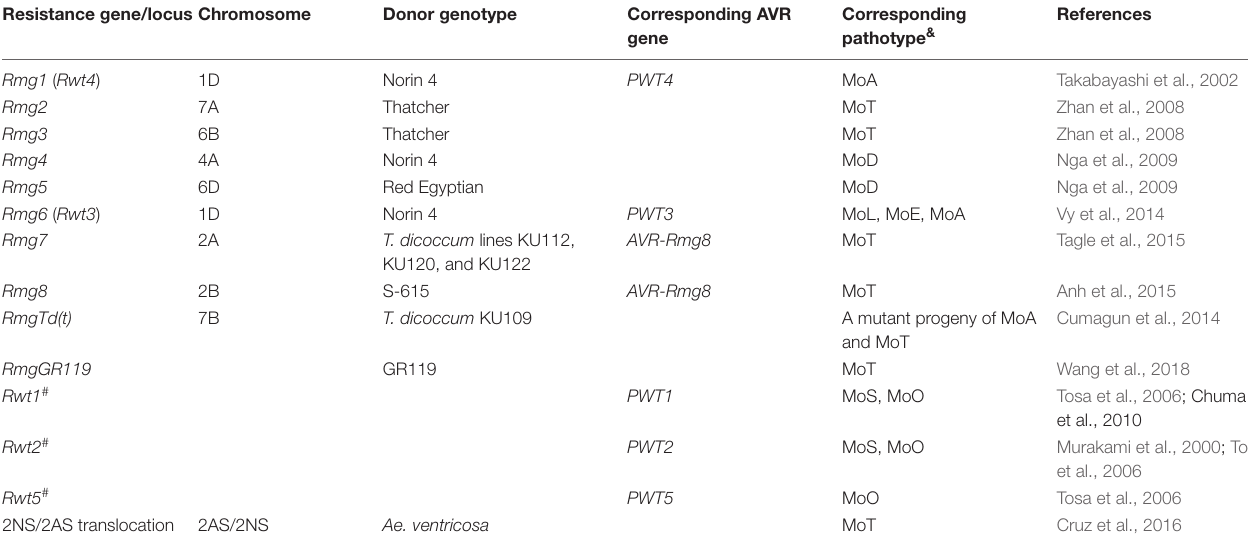
TABLE 1 | List of identified and postulated resistance genes in wheat against different Magnaporthe oryzae pathotypes. Resistance gene/locus